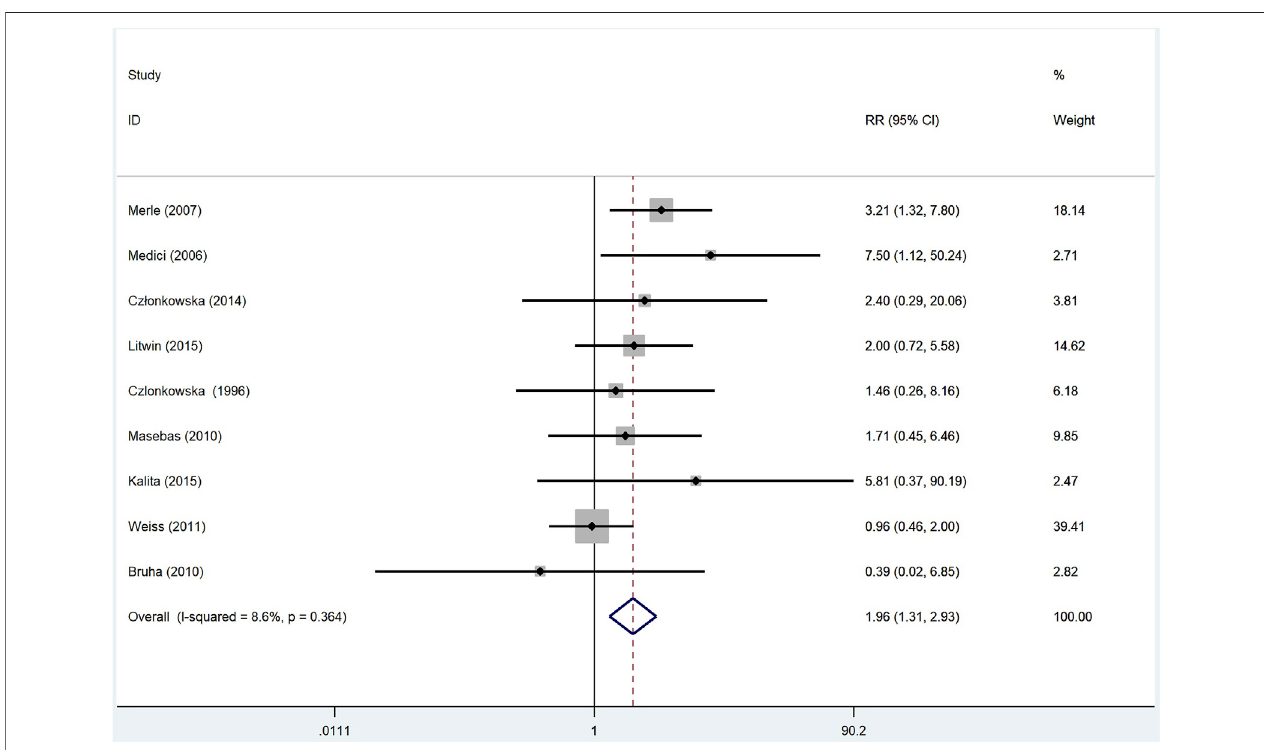
FIGURE 5 | Meta-analysis of neurological deterioration in WD patients treated with D -penicillamine compared with zinc salts.